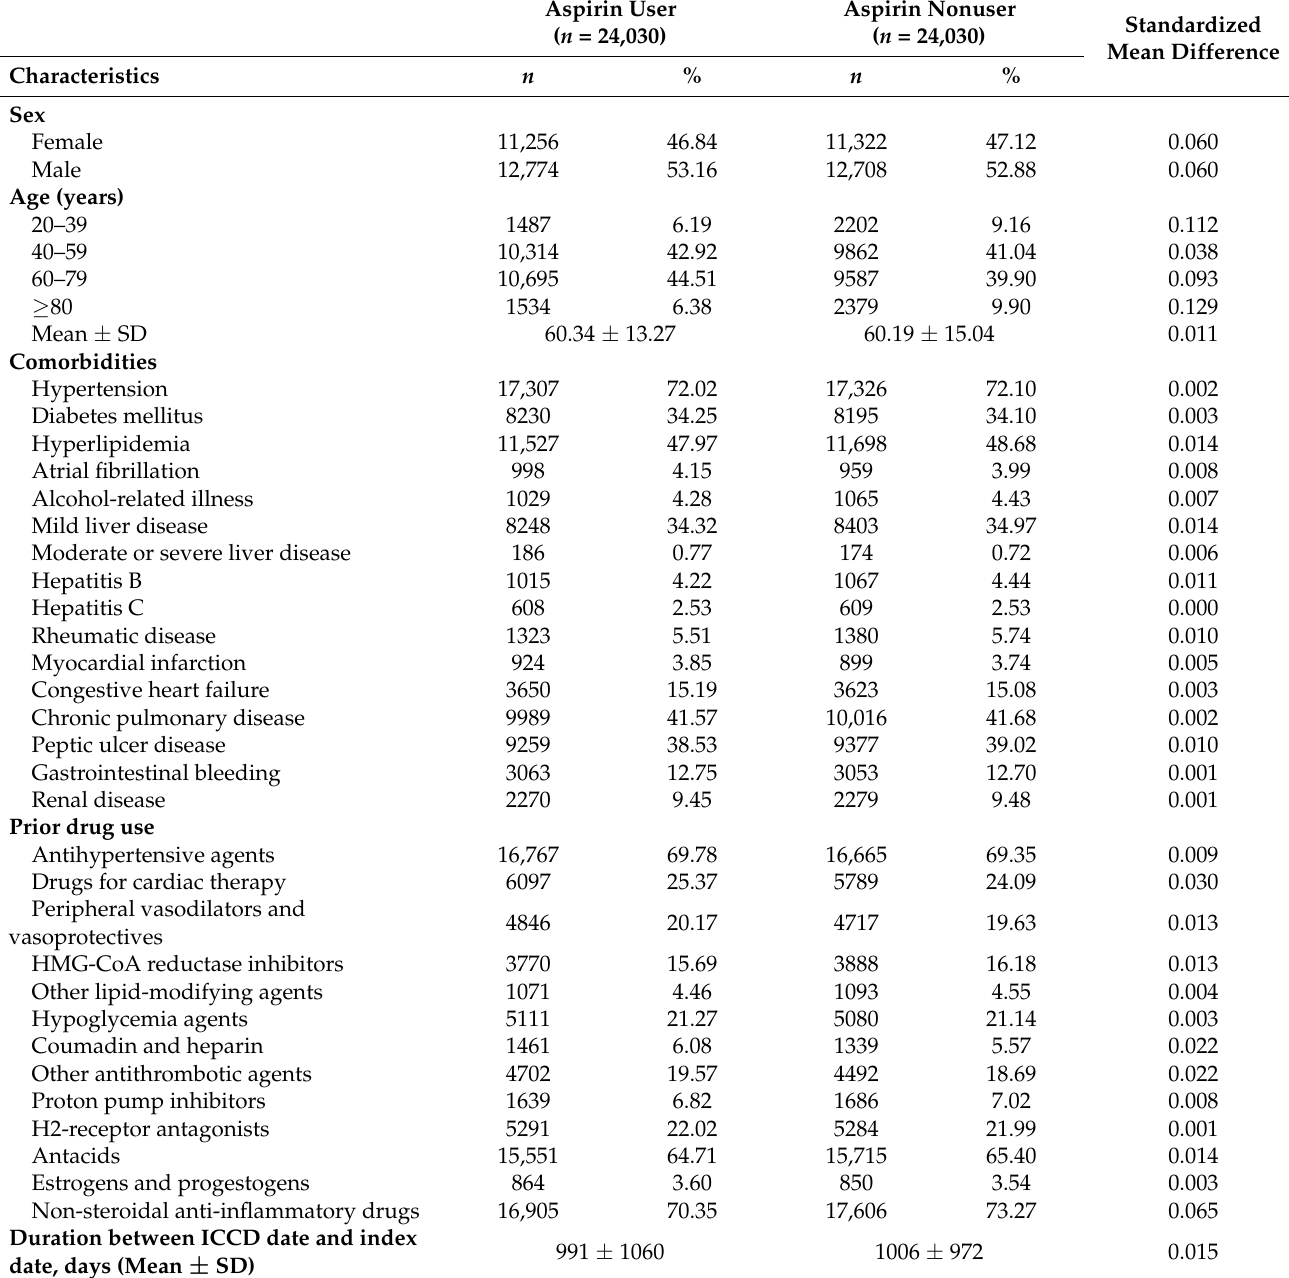
Table 1. Demographic and baseline clinical characteristics of the two propensity-matched study